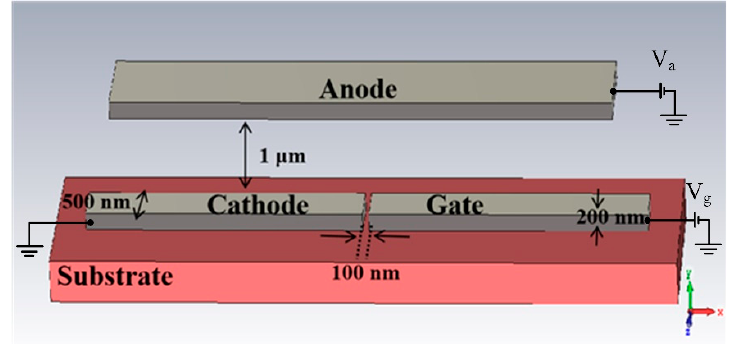
Figure 1. Schematic diagram of the NVC-based electron source. Figure 1 . Schematic diagram of the NVC-based electron source.